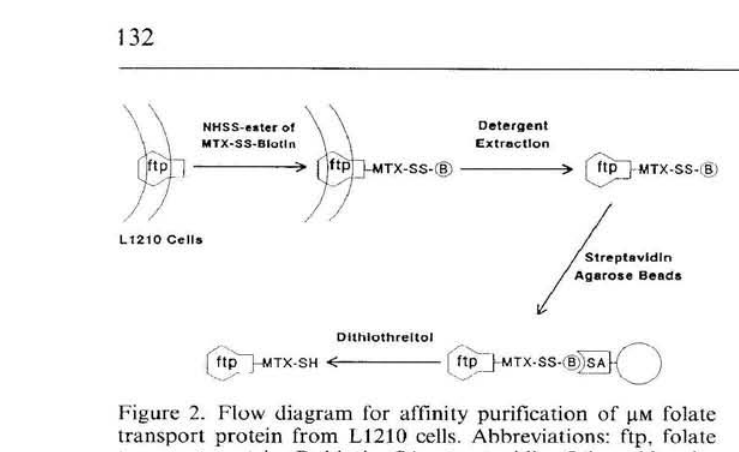
Figure 2. Flow diagram for affinity purification of μΜ folate transport protein from L1210 cells. Abbreviations: ftp, folate transport protein; B, biotin; SA, streptavidin. Other abbrevia- tions are given in the